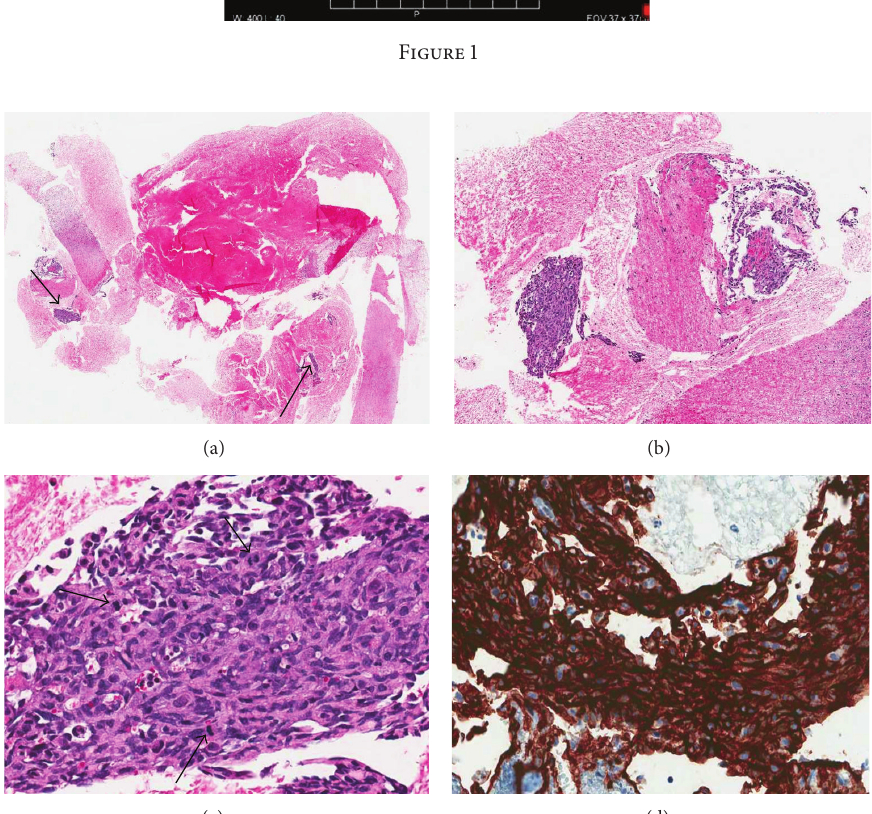
Figure 2: Microphotographs of a renal biopsy. (a) Scant tissue fragments with extensive necrosis (HE, × 40). (b) Scant tissue fragments with extensive necrosis (HE, × 100). (c) Multiple vascular channels lined by pleomorphic endothelial cells and increased mitotic figures (arrows) (HE, × 400). (d) Strong immunoreactivity for an endothelial marker CD34 (IHC, ×